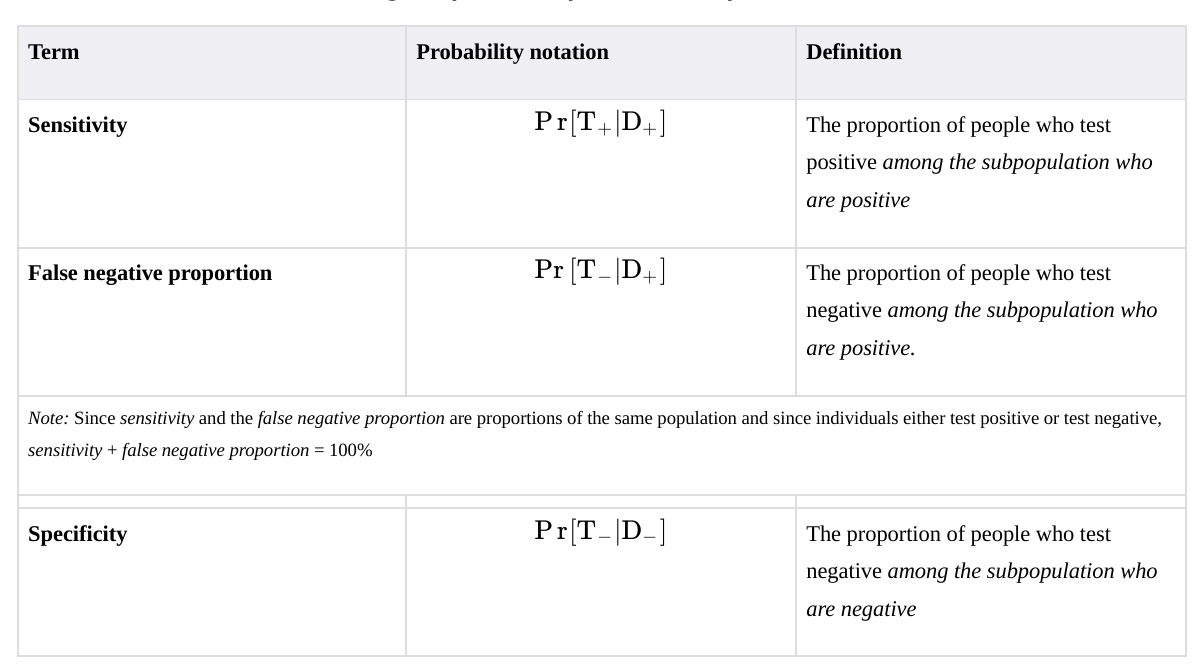
Table 1. A list of terms referring to specific aspects of test performance.